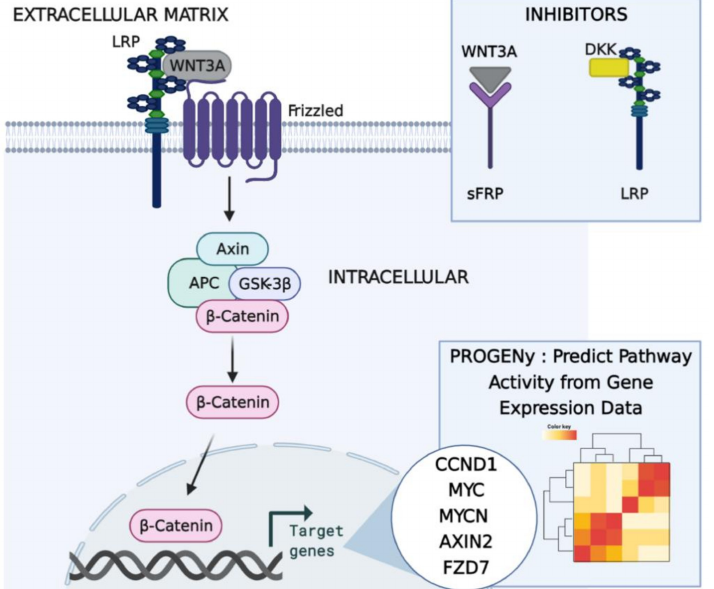
Figure 1. Cascade of events in the WNT Signalling Pathway. Our approach is to combine critical features (genes forming the model) from the most recent mathematical model of the WNT STN, by Kogan et al., with adjustable machine learning models [27]. The schematic represents the initial steps of activation of the WNT pathway. WNT binds to FZD (frizzled), and the co-receptor LRP5/6 (low-density lipoprotein receptor-related protein 5/6), which is recruited in the vicinity of FZD receptors upon WNT binding. This binding prevents the formation of the whole destruction complex consisting of AXIN, APC, and GSK3 β (Glycogen Synthase Kinase 3 Beta), thereby causing rising levels of β -catenin, β -catenin translocation into the nucleus, and expression of WNT target genes, CCND1 (Cyclin D1), MYC, MYCN, AXIN2, and FZD7 [27]. Using machine learning tools, such as PROGENy, the WNT pathway activity can be calculated for each individual patient by analysing their gene expression [35,36]. Created with